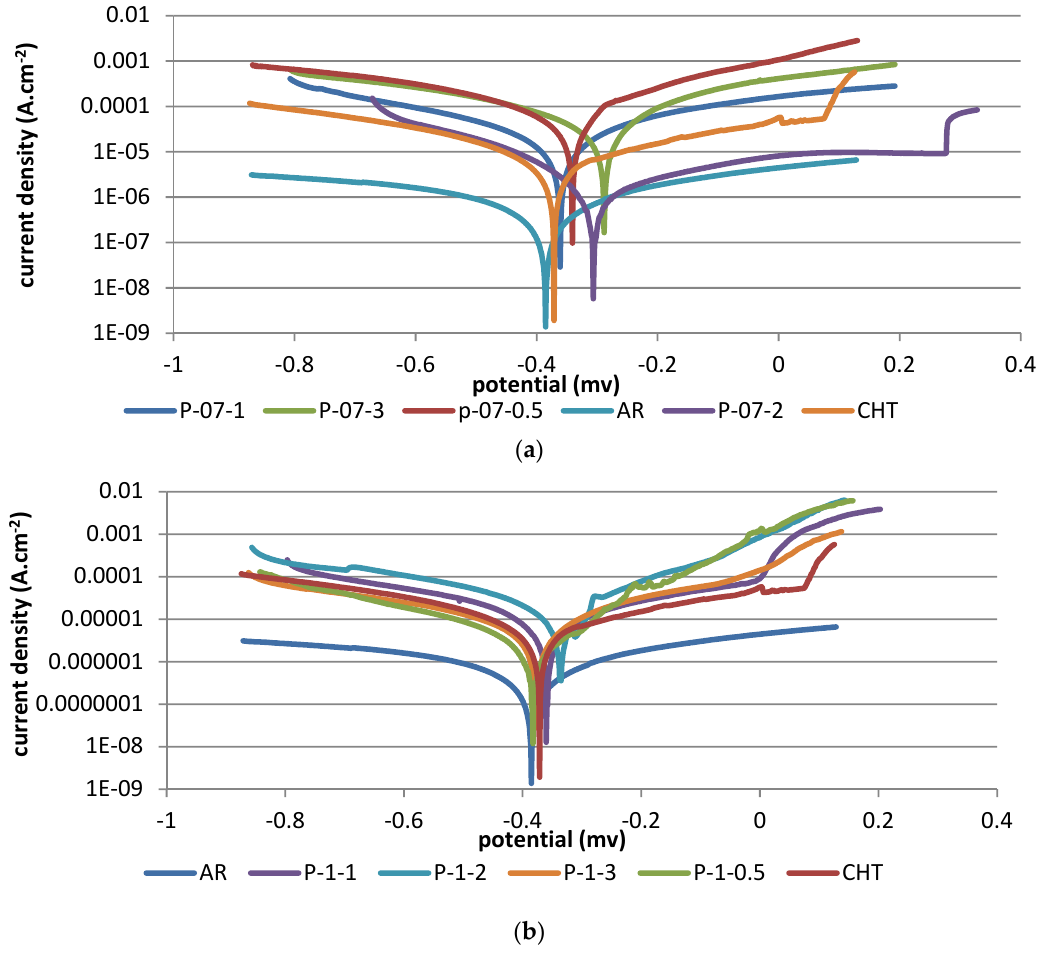
Figure 16. Potentiodynamic polarization curves of AR 416, CHT, and LHT samples treated at four different laser scanning speeds at laser powers of: ( a ) 700 W; and ( b ) 1000 W.